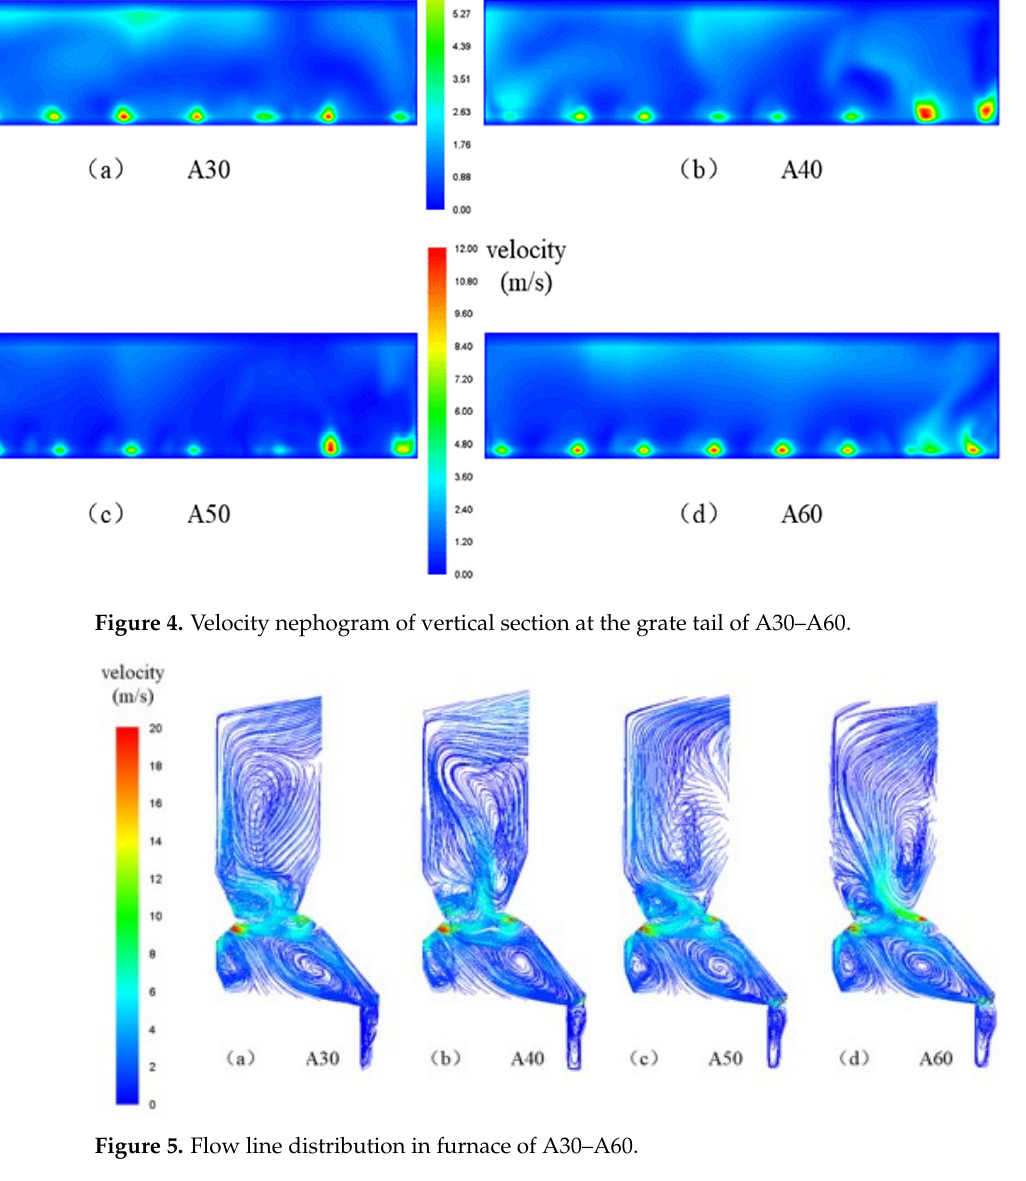
Figure 5. Flow line distribution in furnace of A30–A60. Table 4. Variation of flow field at the grate tail at different flow velocities.